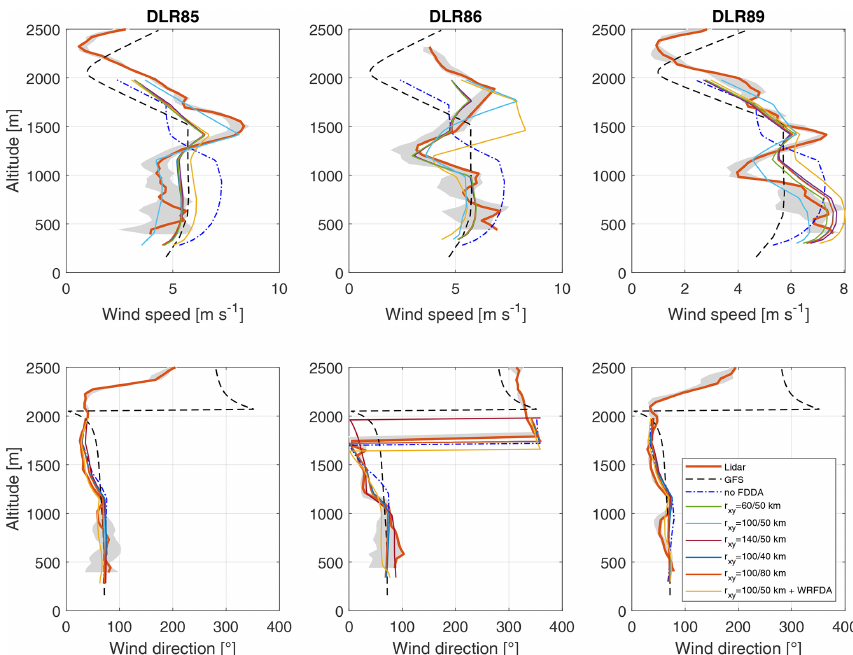
Figure 5. Ensemble WRF runs with varying radii of influence r xy in comparison to interpolated NCEP GDAS/FNL and actual lidar soundings for 6 June 2018 at 09:00UTC. The shaded area shows the maximum variability including soundings timed 20min before and 20min after the observations used. Abscissa units are ms − 1 and